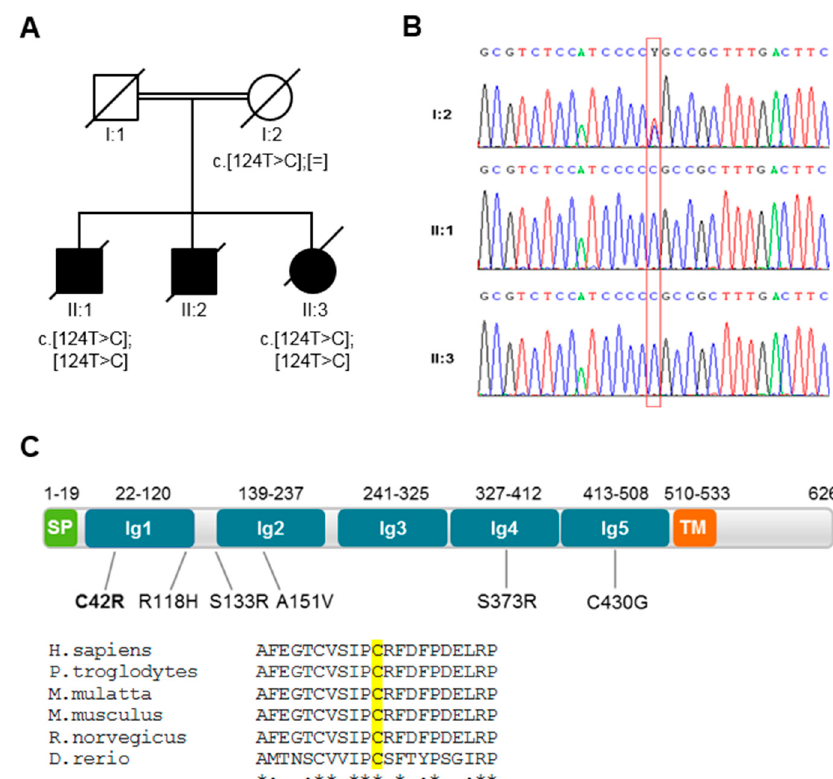
Figure 1. A family pedigree and schematic representation of the myelin-associated glycoprotein (MAG) protein. ( A ) A pedigree with segregation analysis of the new MAG variant (c.124T>C; p.Cys42Arg). Black symbols represent individuals affected by cerebellar ataxia. ( B ) An electropherogram with the position of the c.124C>T variant boxed. ( C ) A schematic representation of the MAG protein (NP_002352.1) with the location of the variant found in this study (in bold) and other variants previously associated with different clinical phenotypes. A sequence alignment of the residues surrounding Cys42 of human MAG against other species is also shown and was performed using the Clustal Omega program.